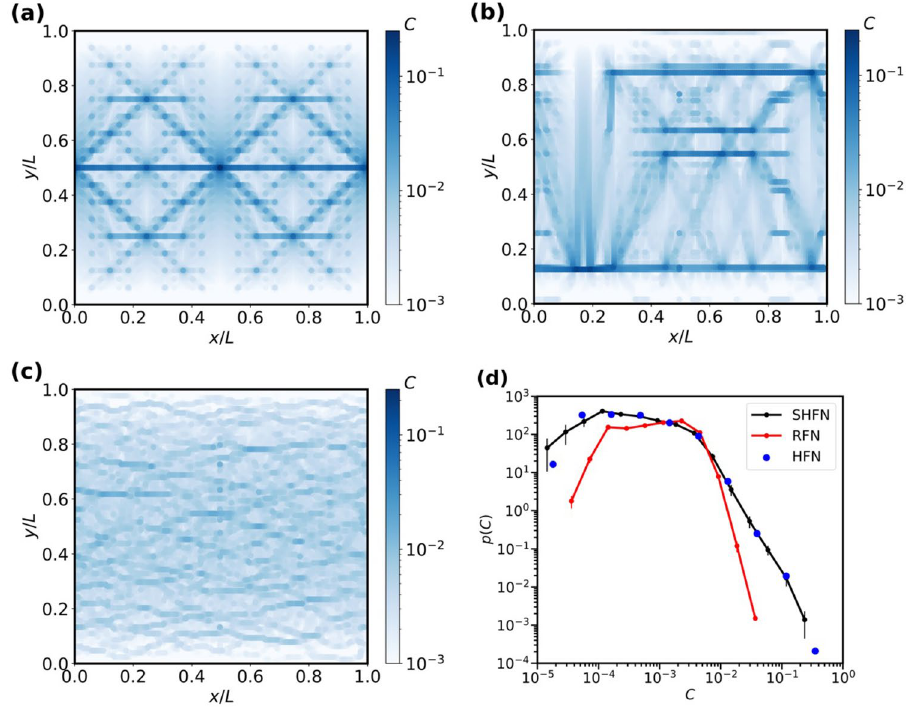
Figure 3. Distribution of geodesic edge betweenness centrality across the network. Network edges coloured based on GEBC values. ( a ) HFN model, ( b ) SHFN model and ( c ) RFN model, all of size L = 128 , ( d ) probability distributions p ( C ) of edge betweenness centrality for the different network models. SHFN and RFN data are averaged over 200 network realizations. HFN and SHFN exhibit the same tail behavior.